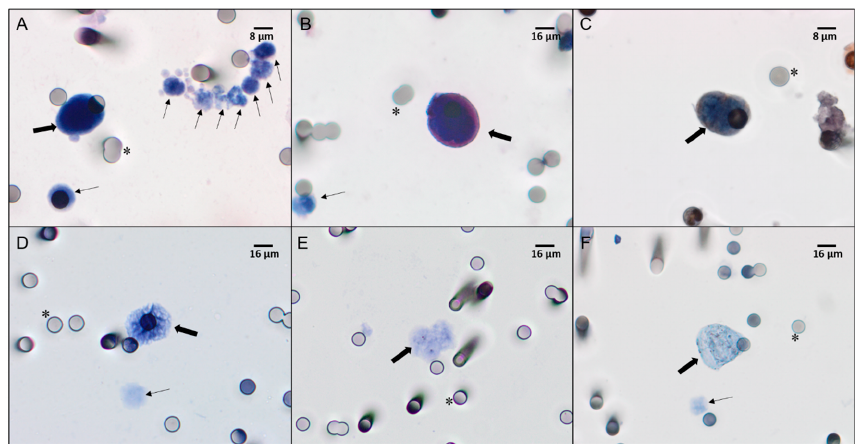
Figure 1. Immunostaining ( A–C ) and chromogenic in situ hybridization (CISH) ( D–F ) of CTCs from locally advanced rectal cancer (LARC) patients. ( A ) CTCs and leukocytes visualized with haematoxylin-eosin staining (×40 magnification). ( B ) CTCs stained with an anti-thymidylate synthase (TYMS)antibody,visualized with Permanent Red, and counterstained with haematoxylin ( × 40 magnification). ( C ) CTCs stained with an anti-RAD23B antibody, visualized with 3,3-diaminobenzidine (DAB), and counterstained with haematoxylin ( × 60 magnification). ( D ) CTCs negative for TYMS mRNA and counterstained with haematoxylin ( × 40 magnification). ( E ) CTCs with a low TYMS mRNA signal (normal expression) counterstained with haematoxylin( × 40magnification). ( F )CTCswithahigh TYMS mRNAsignal(overexpression)counterstained with haematoxylin ( × 40 magnification). All images were analyzed on a Research System Microscope BX61 (Olympus, Tokyo, Japan) coupled to a digital camera (SC100–Olympus). Thick arrows indicate CTCs, thin arrows indicate leukocytes, and asterisks indicate 8 µ m pores of the ISET ®